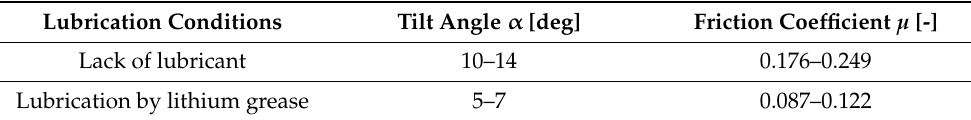
Table 3. Measured values of tilt angle α and the related friction coefficient µ in contact between steel and material of ball joint bearing, both unlubricated and lubricated by lithium grease.